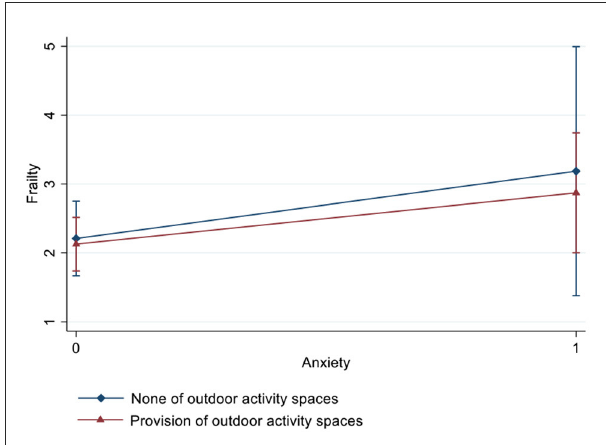
FIGURE2 Interaction effect of anxiety and outdoor activity spaces on frailty estimated based on a fully adjusted model (including age, years of education, marital status, economic conditions, comorbidities, cognitive impairment, loneliness, and nutritional status).